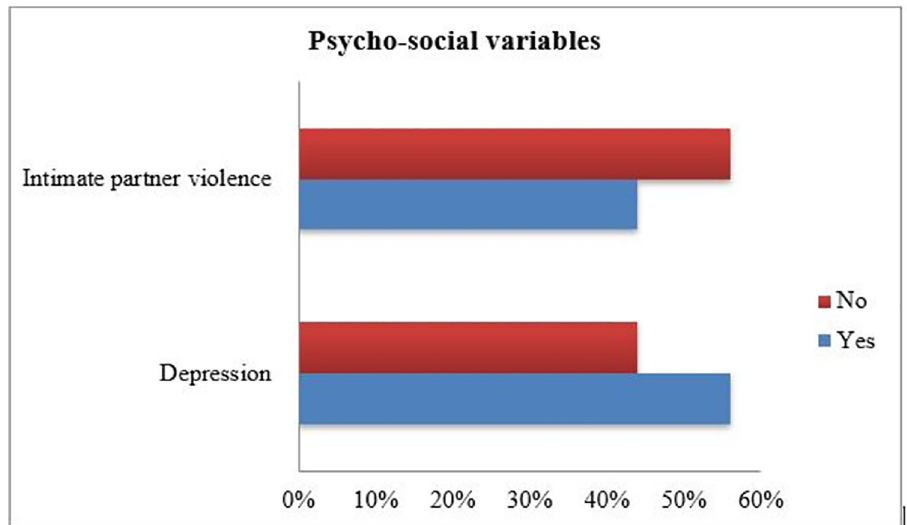
Fig 1. Descriptive psycho-social results of respondents Dec, 2020 (N = 423).